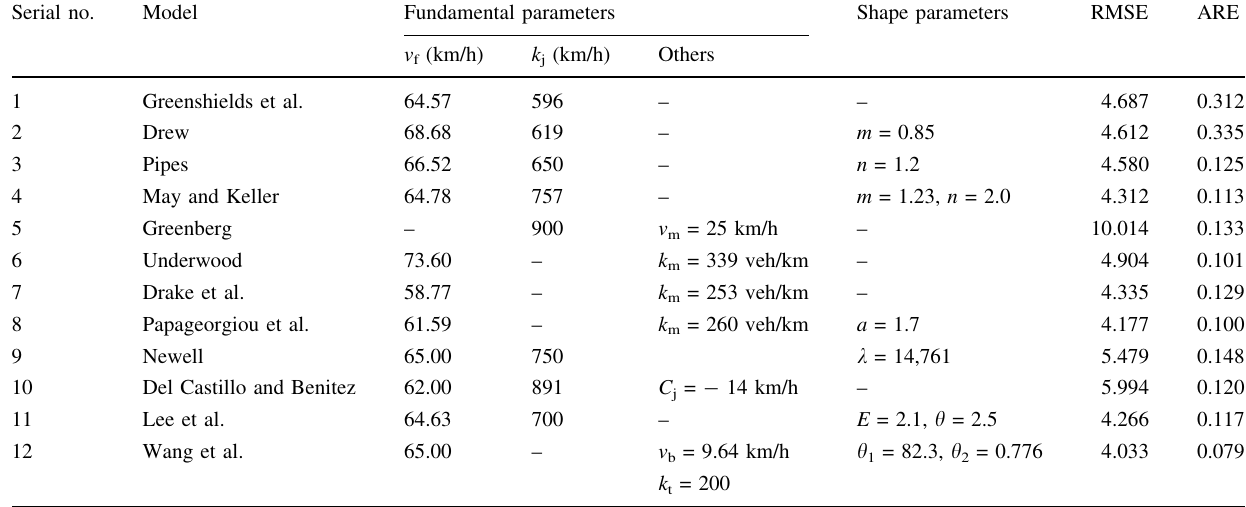
Table 4 Model parameters and fitness